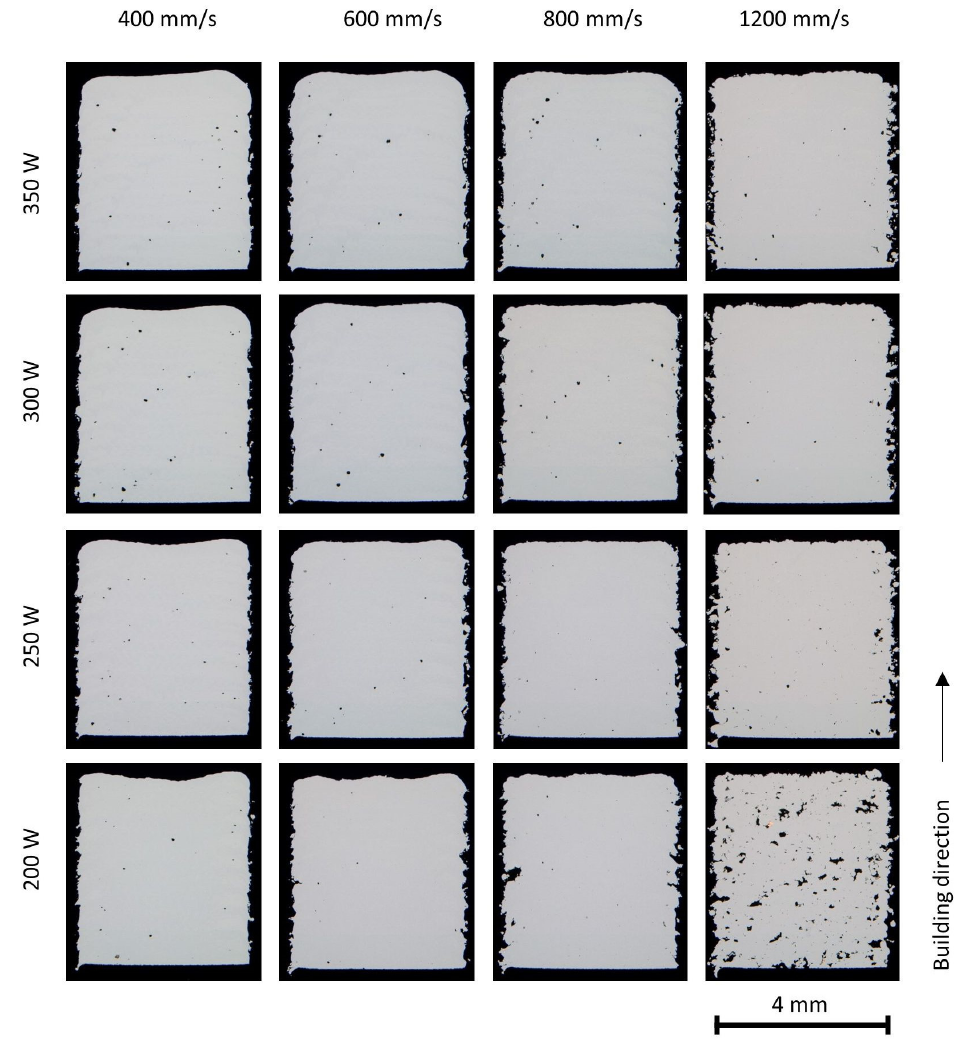
Figure 7. Stereo microscopy of the X2CrNiMoN25-7-4 cubes (4 × 4 × 5 mm 3 ) built with various process parameters.